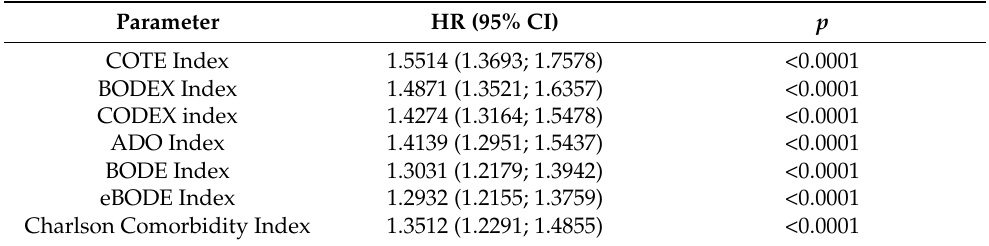
Table 6. Ten-year survival hazard ratios for multidimensional indices in the Cox regression model.